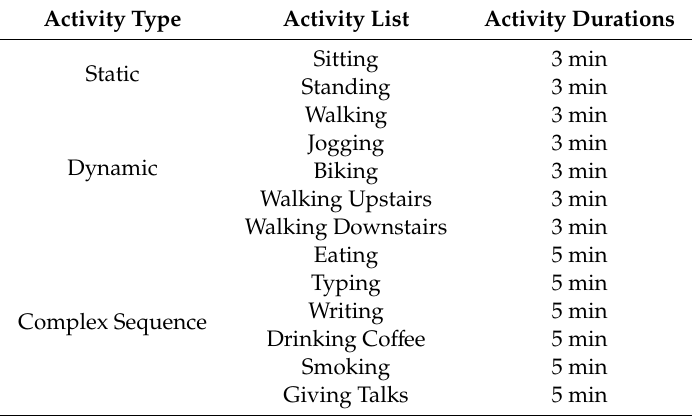
Table 2. Data description and pre-processing